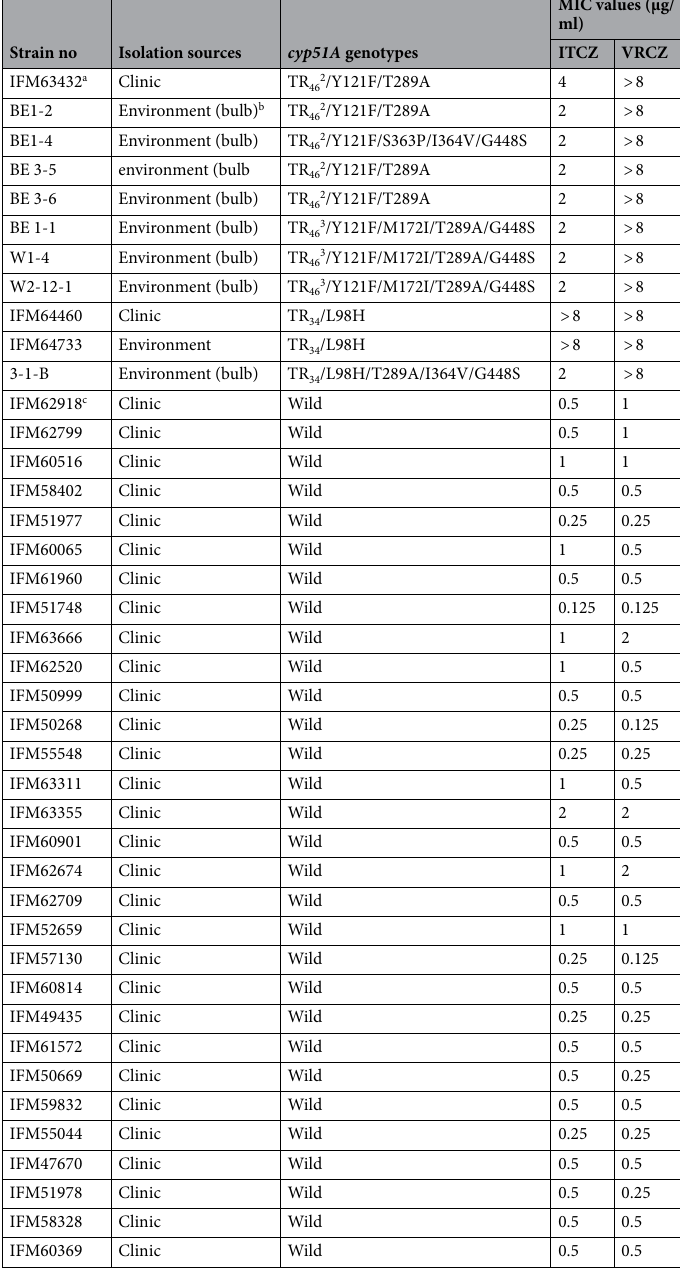
Table 1. Aspergillus fumigatus strains used in this experiment and their drug susceptibility profiles against itraconazole and voriconazole. ITCZ itraconazole, VRCZ voriconazole. a LAMP positive control strain. b obtained from plant bulbs. c LAMP negative control